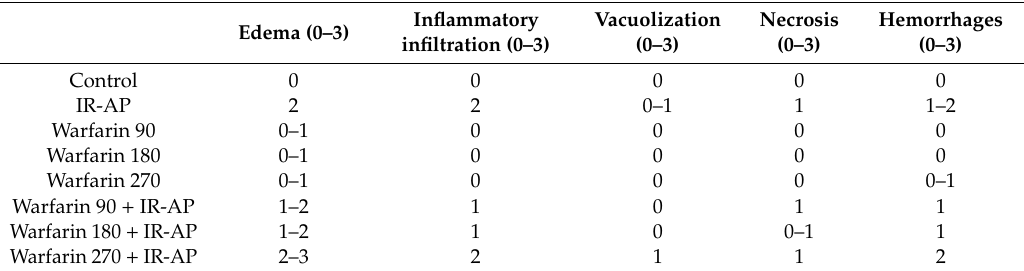
Numbers represent the predominant histological grading in each